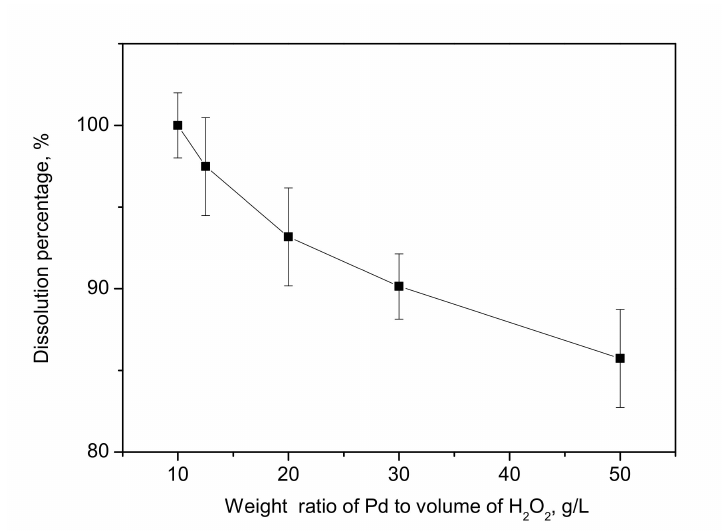
Figure 4. Effect of the weight ratio of Pd to H 2 O 2 on the dissolution of Pd. Conditions: TBP = 3 M; diluent: kerosene; Pd/HCl ratio = 10 g/L; 60 ◦ C, 60 min.